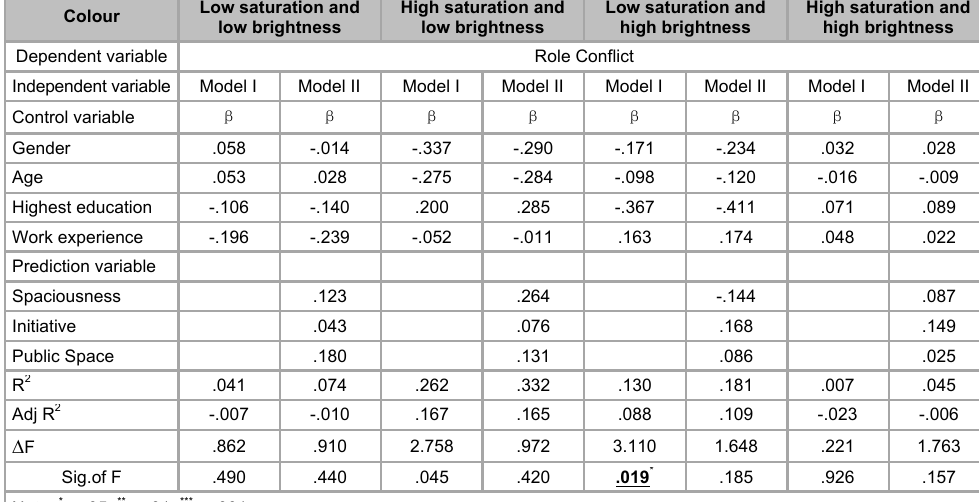
Regression analysis of the moderating effects of Colour on the relations between Office Space and Work Stress (Role